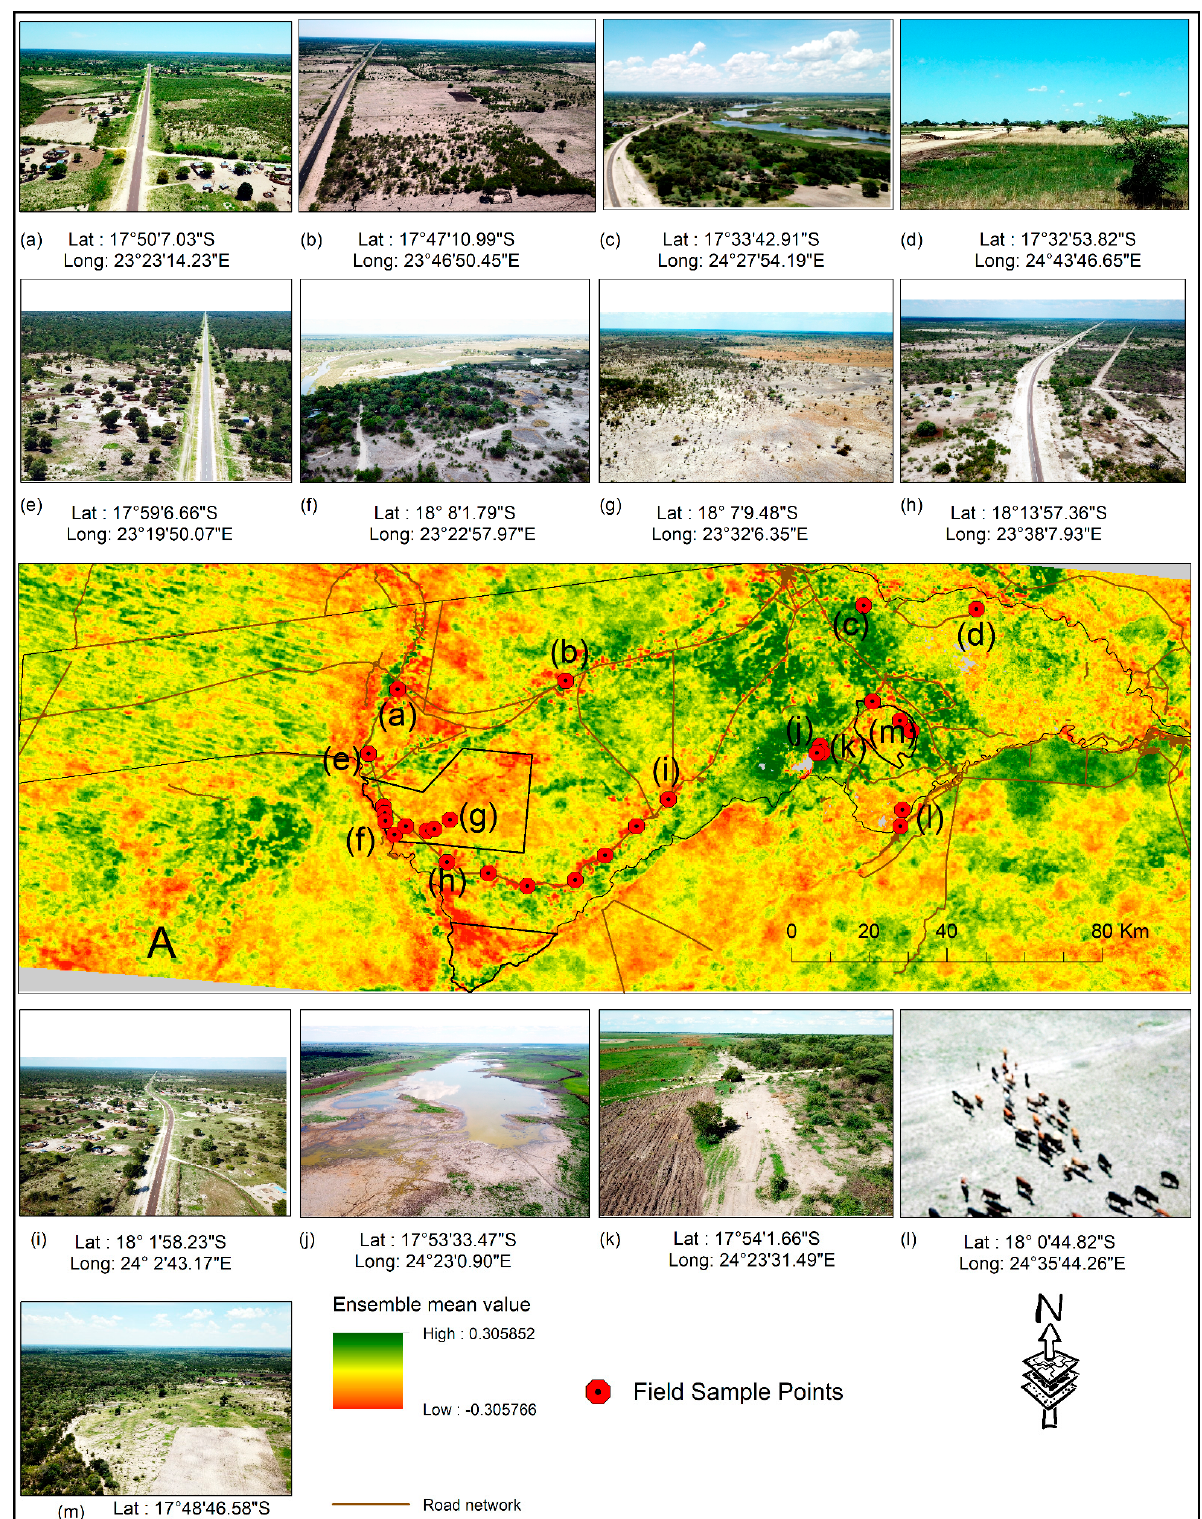
Figure 4. Shows aerial images from our 2019 field survey in the Zambezi region ( a – m ). In (A), the labels ( a – m ) correspond to the images shown with their respective GPS coordinates at the sample locations (red circle with black dot in the middle). Additionally, in (A), we use the same ensemble as in Figure 2b above for reference